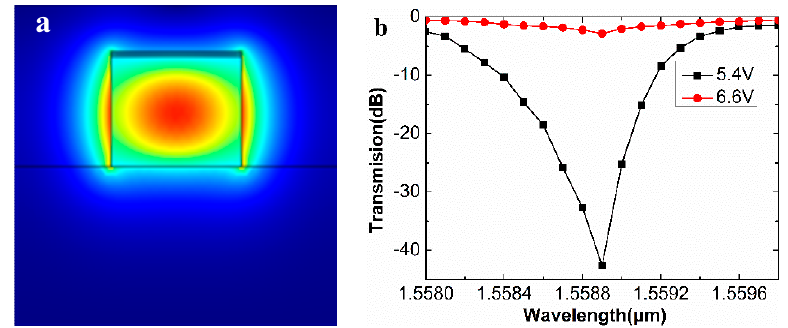
Figure 4. ( a ) Power density of the electric field of the fundamental transverse electric ( TE) mode. ( b ) Transmission curve as a function of the wavelength.